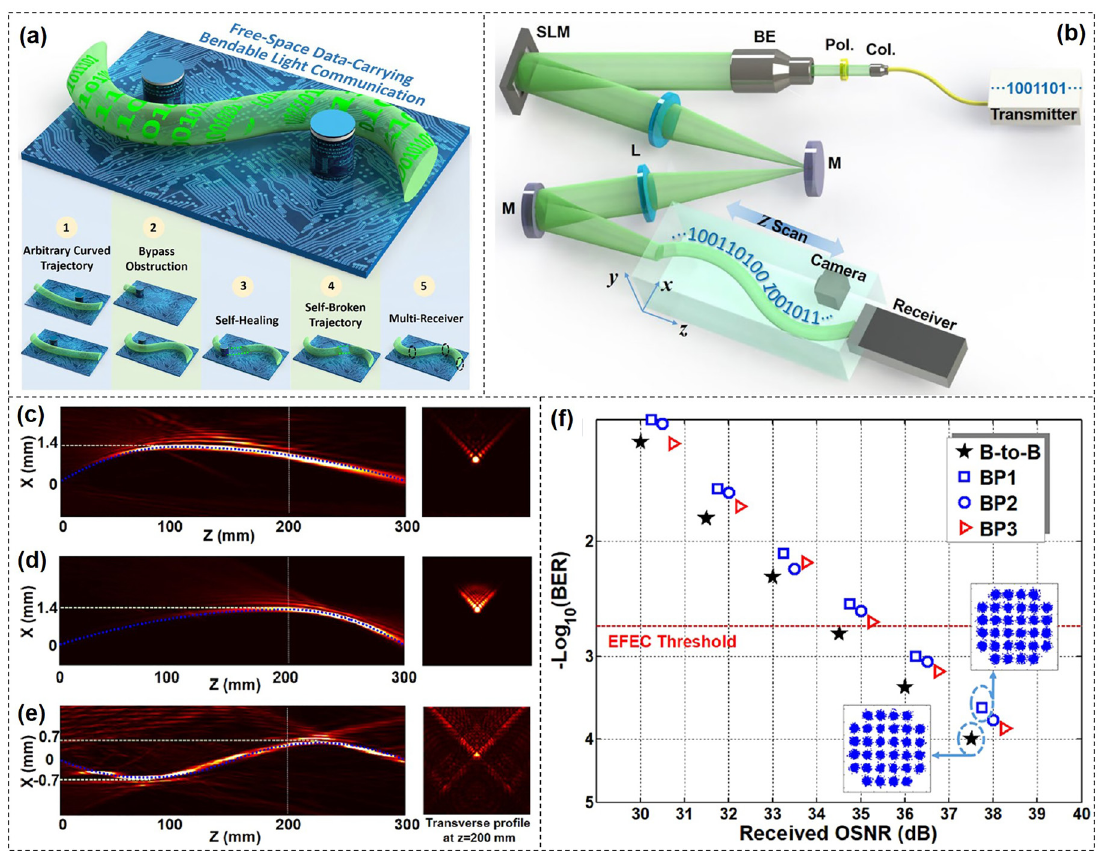
Figure 20: Free-space data-carrying bendable light communications. (a)Conceptandprincipleoffree-spacedata-carryingbendablelightcommunications.(b)Experimentalconfigurationoffree-spacebendablelight communications.Col.:collimator; Pol.: polarizer; BE: beamexpander; SLM:spatial light modulator;M:mirror; L:lens.(c – f)Experimentalresults offree-spacebendablelightcommunicationsalongarbitrarytrajectories.(c – e)Measuredintensitydistributionsofthreedifferentbendablelight beams at x – z plane (the blue dashedline was the preset trajectory) and corresponding transverse intensity pro fi les at z = 200 mm. (f) Measured BER performance of the three different data-carrying bendable light beams. Insets showed constellations of 32-QAM DMT signals [122]. Reprint permission obtained from